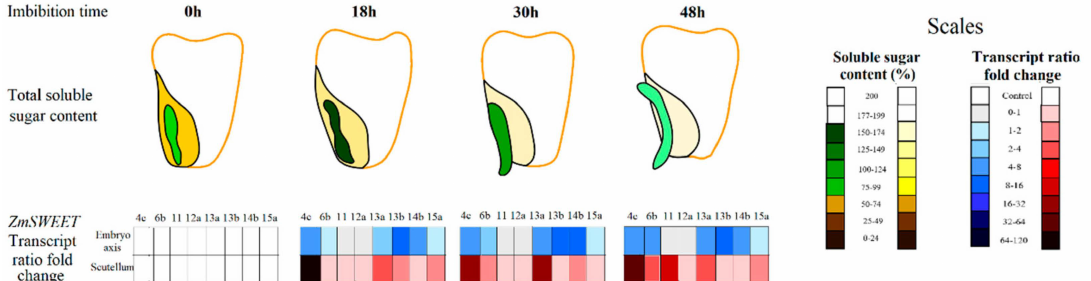
Figure 9. Total soluble sugar content and ZmSWEET transcription level in embryo axis and scutellum along germination. Scales were normalized to total soluble sugar levels with 0 h of imbibition as a control. Transcripts levels determined by qPCR are expressed as a fold of change between 0 h and the indicated